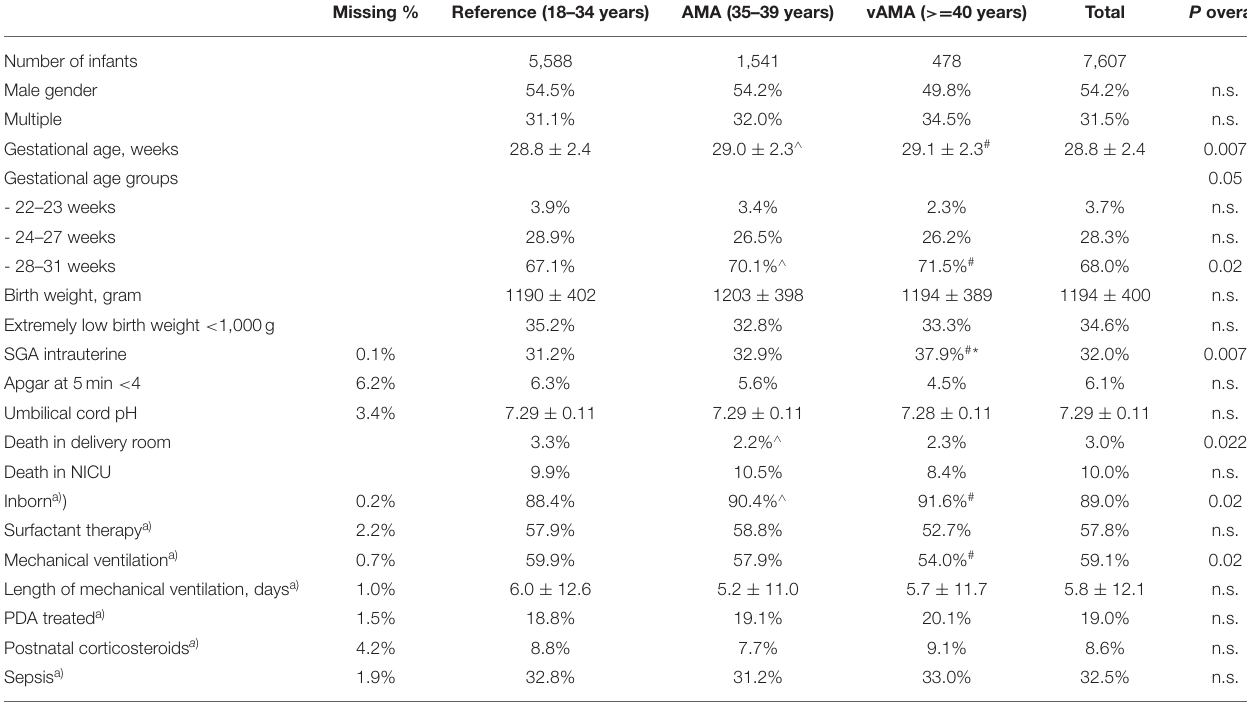
TABLE 2 | Neonatal characteristics of infants by maternal age